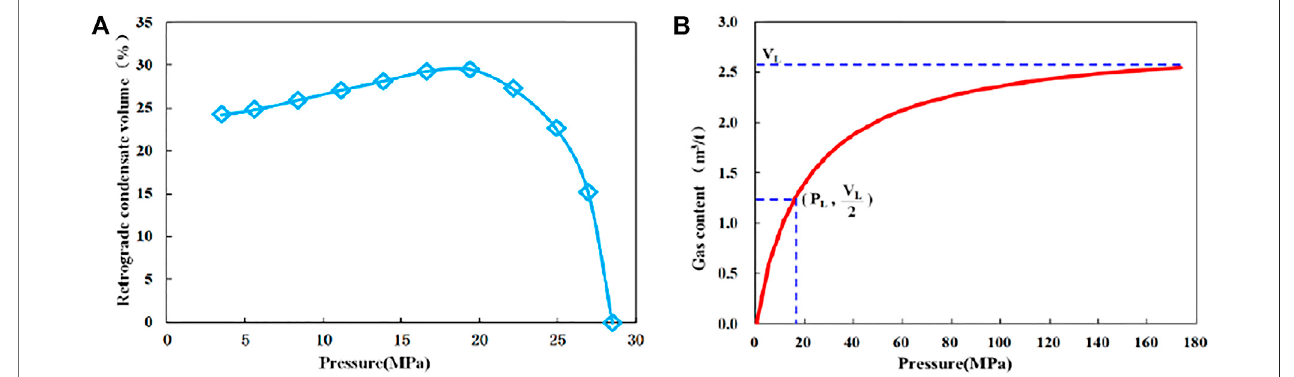
FIGURE 1 | Volume fraction change of condensate oil in CVD experiment (A) and Langmuir equilibrium absorption curve (B) .